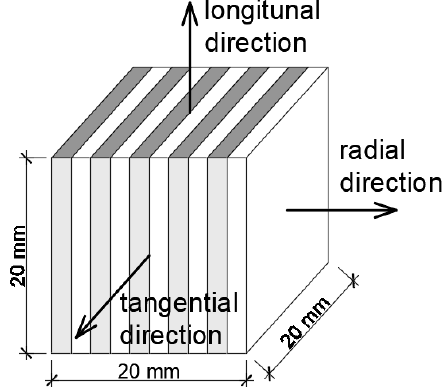
Figure 4. The cubic wood sample.